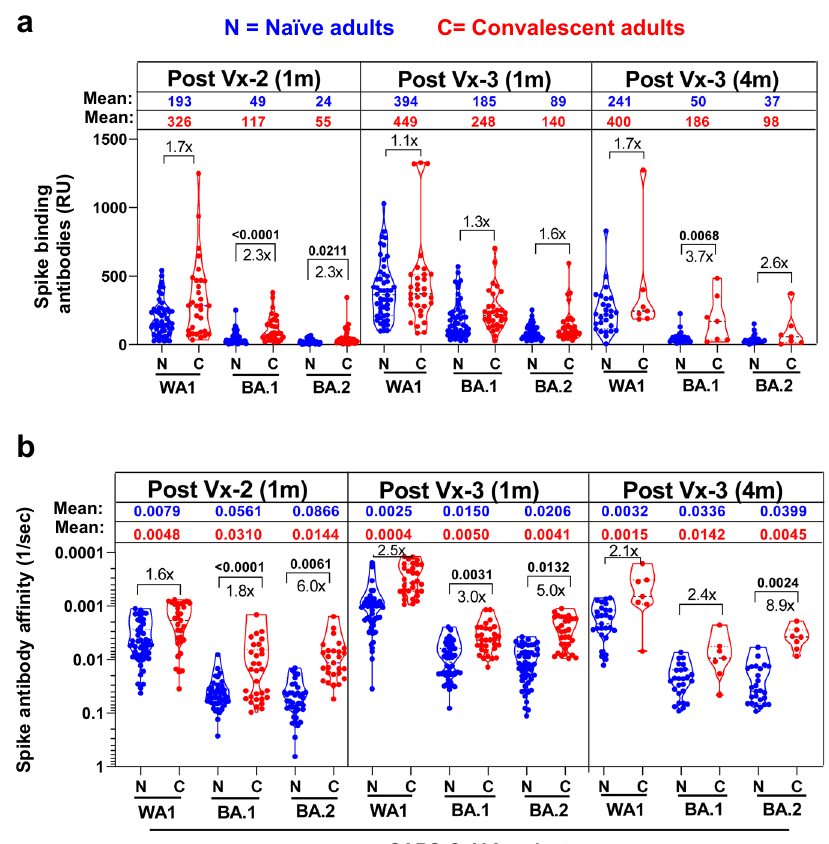
Fig.2|Antibodyaf fi nitymaturationofhumanantibodyresponsetoSARS-CoV- 2 spike of WA1 and Omicron subvariants BA.1 or BA.2 following second and third SARS-CoV-2 mRNA vaccination in naïve vs. convalescent adults. a Mean values±rangeoftotalantibodybinding(determinedbymaximumresonanceunits, MaxRU)of1:10dilutedserumsamplesof50unexposednaïve(N;inblue)adultsvs. 31COVID-19convalescent(C;inred)adultsat1maftersecond(Vx-2)orthirdmRNA vaccination (Vx-3) or 4m post-3rd vaccination to puri fi ed trimeric spike of WA1 or Omicron subvariants BA.1 or BA.2 by SPR. The mean values for Max RU for each spike are color coded by each group. b Polyclonal antibody af fi nity maturation (as measured by dissociation off-rate per sec) to SARS-CoV-2 spike proteins for 1m after second (Vx-2) or third mRNA vaccination (Vx-3) or 4m post-3rd vaccina- tion for serum samples from 50 unexposed naïve (N; in blue) and 31 COVID-19 convalescent (C; in red), adults were determined by SPR. Antibody off-rate con- stants that describe the fraction of antibody-antigen complexes decaying